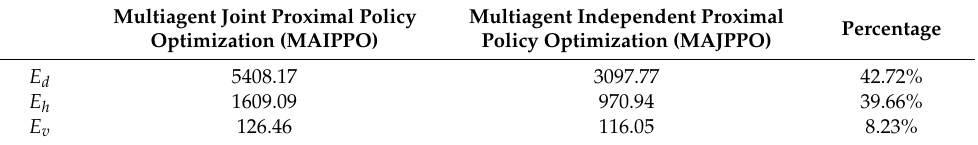
Table 1. The sum of first-order absolute center moment.